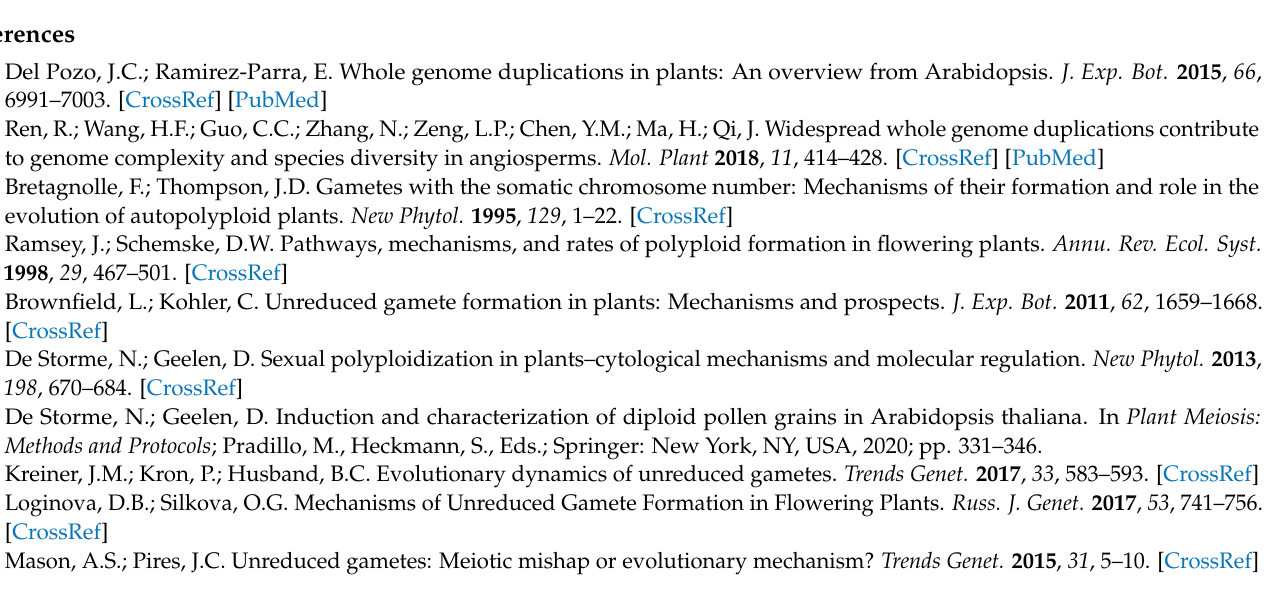
Phenotyping of F1 plants obtained by crossing homozygous mmr1 mutant with wild-type L er plants; Supplementary Figure S8. Whole genome sequencing analysis of pooled mmr1 /L er F2 plants showing the large pollen phenotype; Supplementary Table S1. Primer for genotyping of F1 progenies ( mmr1 crossing with wild-type L er ); Supplementary Table S2. Quantification of mmr1 meiotic restitution